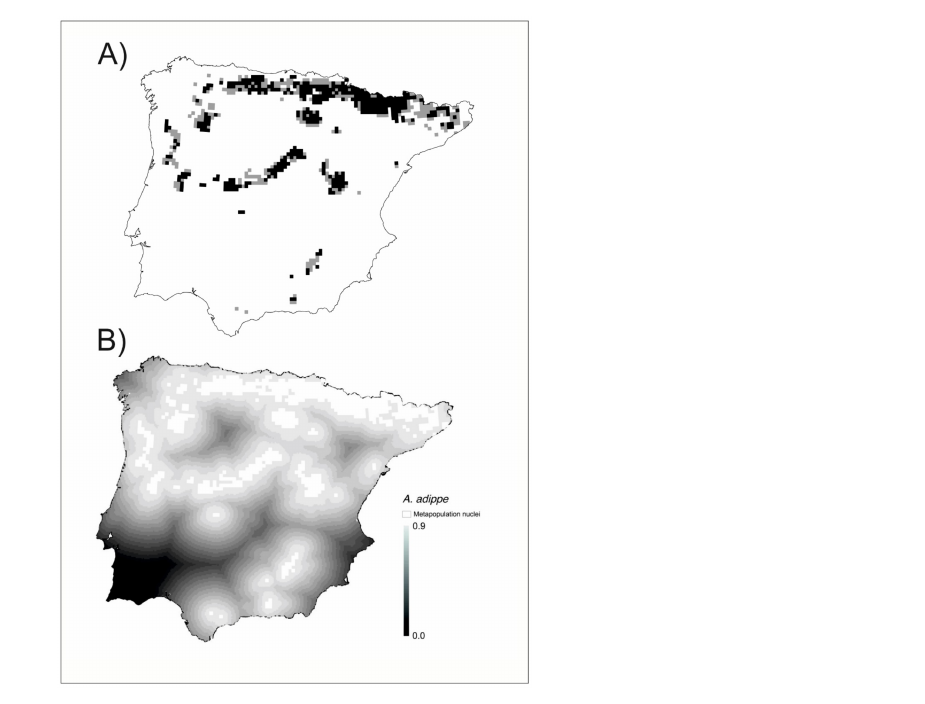
Figure 2. ( A ) Metapopulation patches of Argynnis adippe . In black, the grids with high favorability (F ≥ 0.8) and established presence, in grey those with high favorability (F ≥ 0.8) and undetected presence. ( B ) Connectivity gradient between metapopulation nuclei (white plots). The matrix has been graded on a scale of eighteen levels of connectivity with a 0.05 connectivity range each (represented in grayscale).